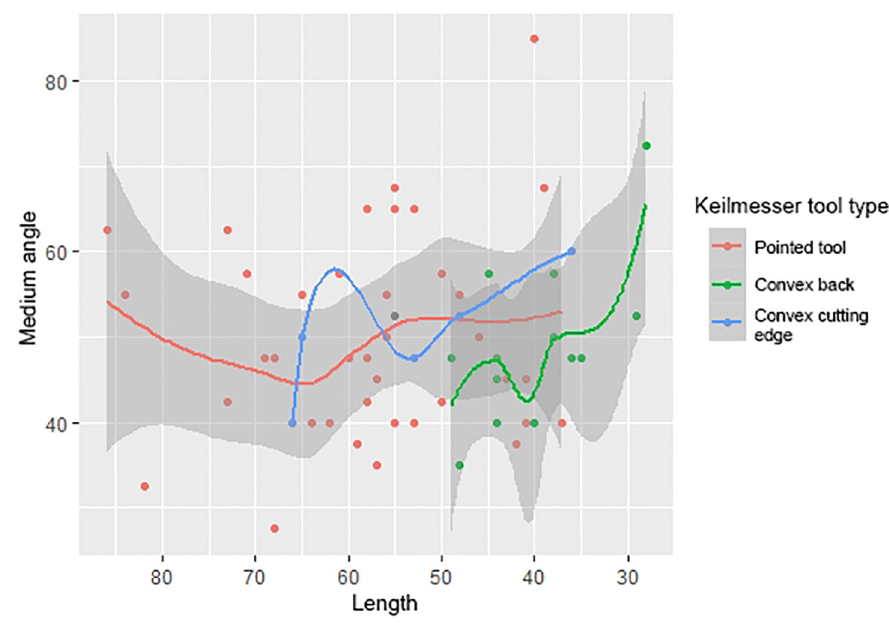
Fig 17. Distribution of the cutting edge angle of keimessers’ groups according to the blank